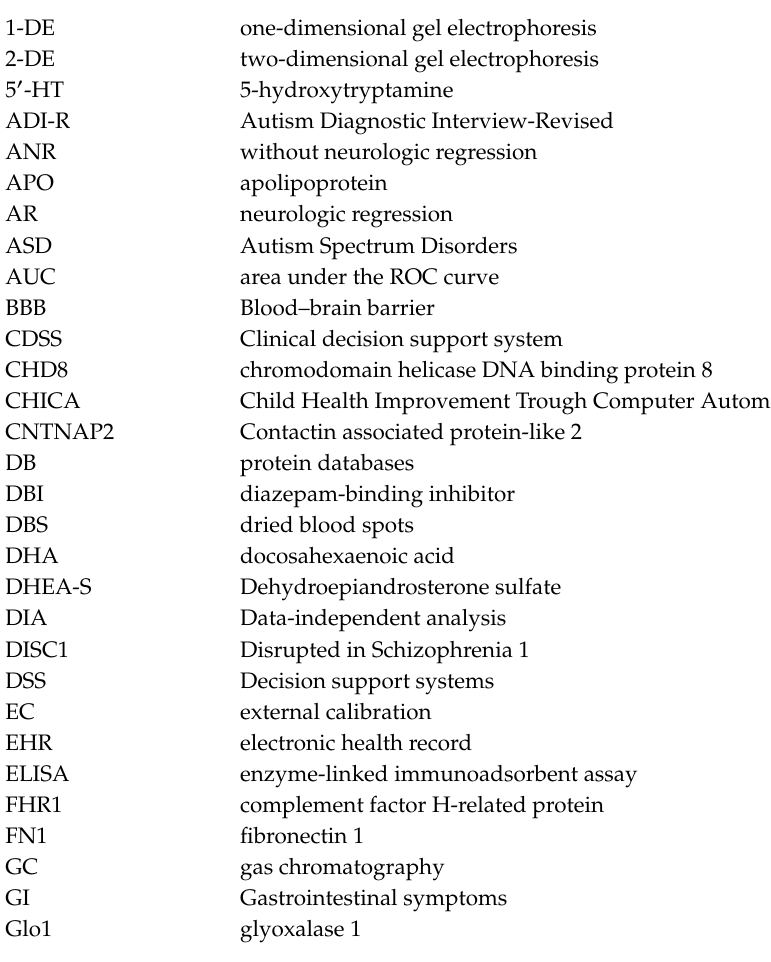
Table S1: Table of all proteins with UniProt code with associated